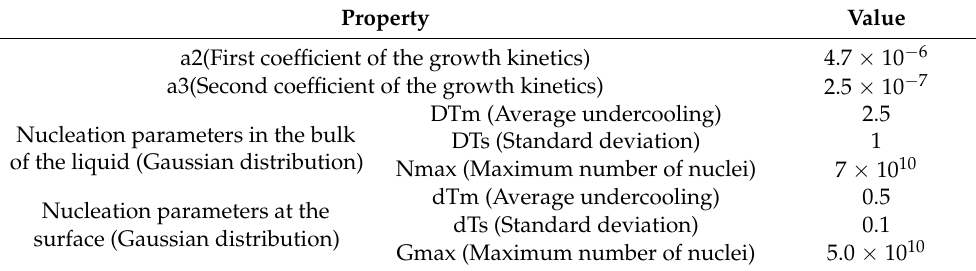
Table 2. The in-built parameters used in ProCast’s CAFE simulation.